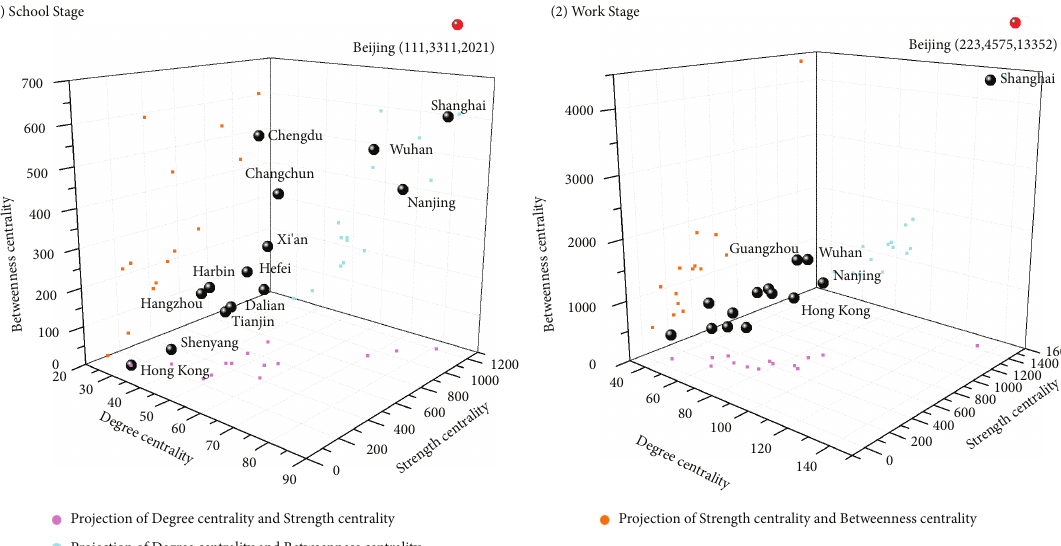
Figure 6: Centrality of network nodes. Note: only the top 15 nodes of comprehensive centrality are shown in the figure. Because Beijing has a high centrality and affects the visualization of the results, it is listed separately. (a) School stage. (b) Work